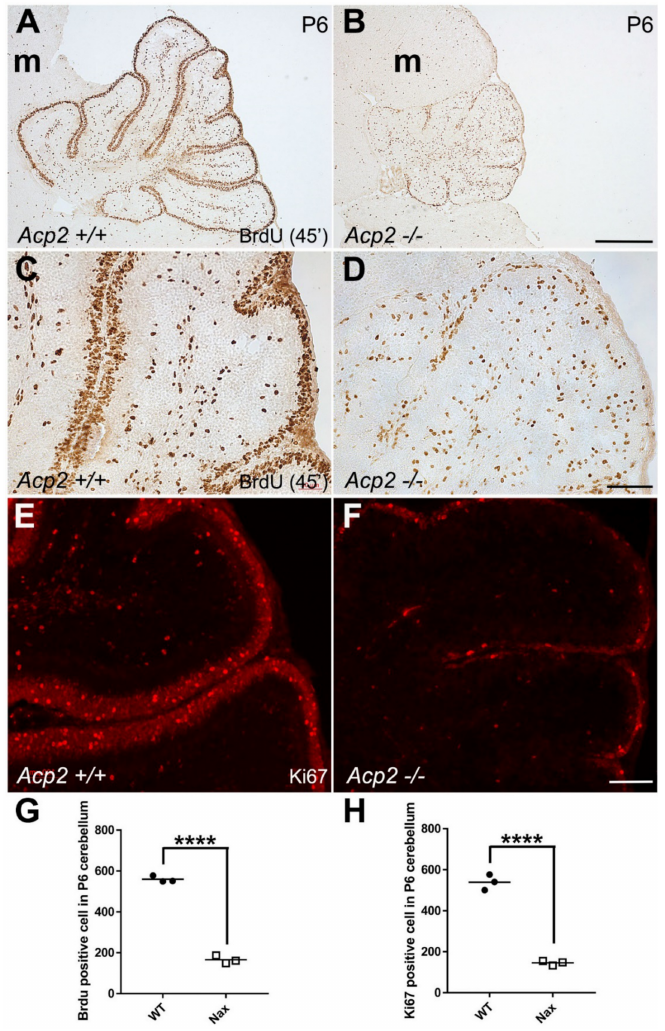
Figure 4. Using BrdU and ki67 to assess GC proliferative activity in wt and nax cerebella at P6. ( A – D , G ) Visualization of BrdU incorporation in nax and wt cerebellar sagittal sections, 45 min after BrdU injection at P6. BrdU staining revealed a higher number of proliferating (immunopositive) cells in the EGZ in wt (( A ), higher magnification in ( C )) as compared to nax cerebellum (( B ) and higher magnification in ( D )). Number of proliferating cells in the EGZ that are BrdU immunopositive is significantly higher in wt than in nax littermates (wt; n = 3 and nax ; n = 3). Quantitative analysis shows that the BrdU + index is about 30% in nax compared to wt. ( E , F , H ) Ki67 immunostaining of cerebellar sections confirmed that the number of proliferating cells in the EGZ is higher in wt ( E ) than in nax mice ( D ). Similar to the BrdU results, cell counting of sagittal sections at P6 shows a significant reduction in the number of Ki67 positive cells in the EGZ in the nax cerebellum than in wt littermates (wt; n = 3 and nax ; n = 3). The data in the graph are presented as the mean ± SEM, and statistical analysis was performed using unpaired t -test (**** p < 0.0001). Abbreviation: m, mesencephalon. Scale bars: 500 µ m in ( B ) applies to ( A , B ), 100 µ m in ( D ) applies to ( C , D ), 100 µ m in ( F ) applies to ( E , F